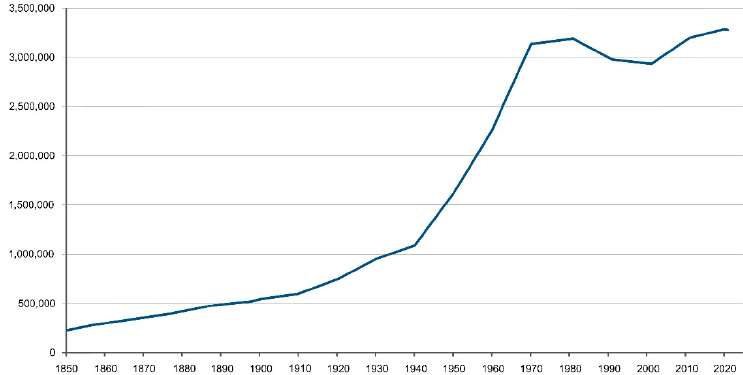
Figure 1. Evolution of the population of Madrid: year–inhabitants. Source: Created by the authors based on data from the Spanish National Institute of Statistics, INE 2022.